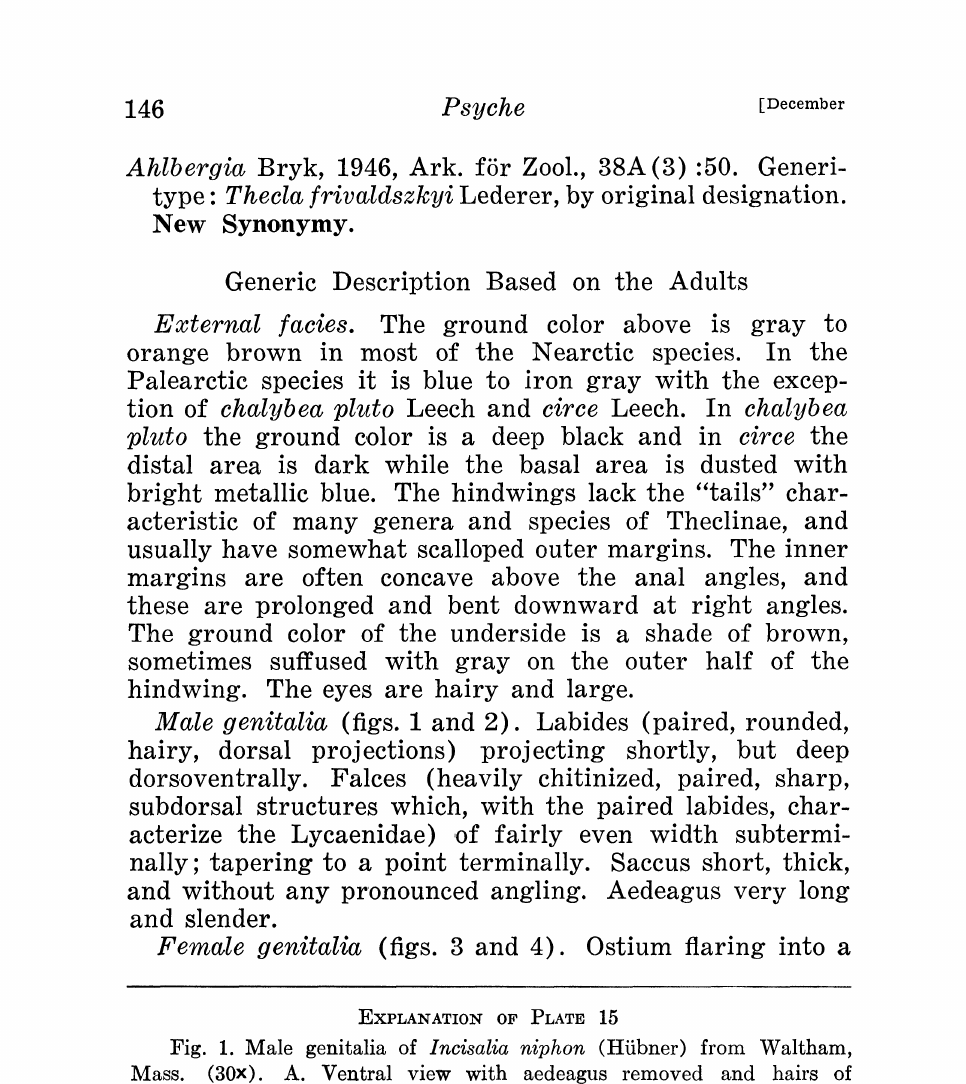
Fig. 1. Male genitalia of Incisalia niphon (Hiibner) from Waltham, Mass. (30x). A. Ventral view with aedeagus removed and hairs of harpes not shown. B. Inset of a harpe showing hairs. C. Lateral view of aedeagus. Fig. 2. Male genitalia of Incisalia ]rivaldsztyi (Lederer) from South Korea (30x). A. Ventral view with aedeagus removed and hairs of harpes not shown. B. Lateral view of aedeagus. Fig. 3. Female genitalia of I. niphon (Hiibner) from Tyngsboro, Mass., ventral view (9.9x). Fig. 4. Female genitalia of I. ]rivaldsztyi (Lederer) from Okean- skaia, Ussuri, ventral view (9.9x). All specimens in the collection of the Musuem of Comparative Zoology,